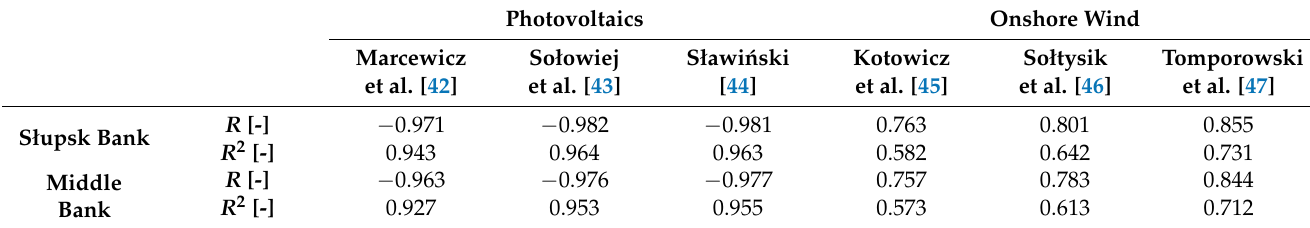
Table 10. Generation in photovoltaic sources and onshore wind sources.